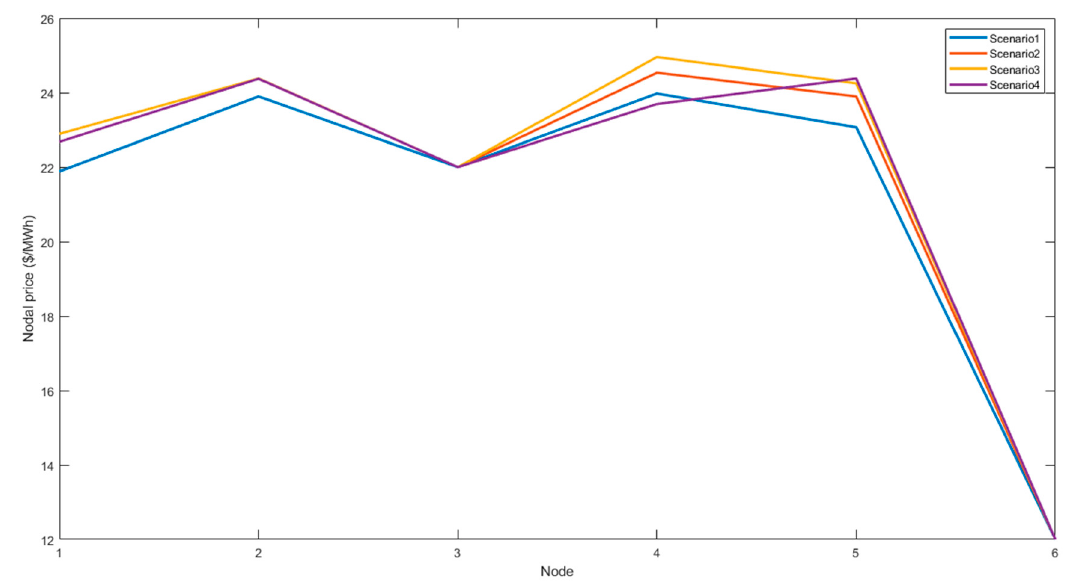
Figure 4. Nodal price without expansion.